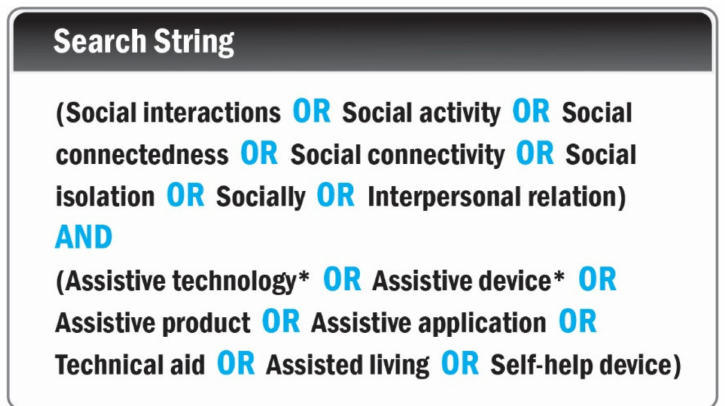
Figure 1. Boolean search string used in the search